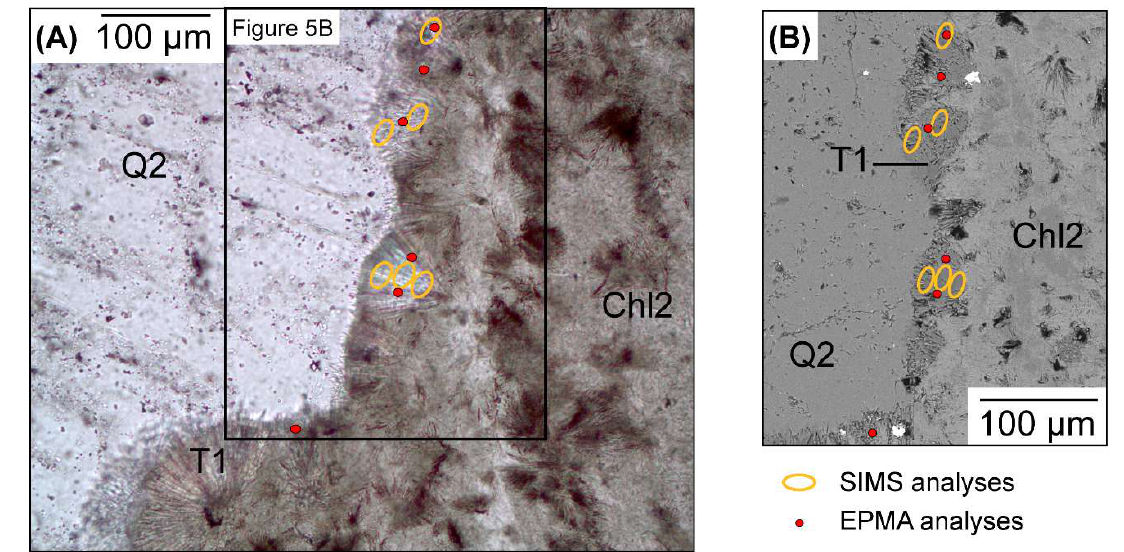
Figure 5. Zoom on the pre‐ore silicification minerals from the Ranger U deposit (Australia): chlorite Chl2, on which very fine‐grained rosettes of tourmaline T1 grow, then cemented by quartz Q2 with locations of the EPMA (red dots) and SIMS (orange ellipses) in situ analyses on tourmaline T1; ( A ) transmitted light. ( B ) BSE image. Sample from drillhole S3PD759 402.9 m.